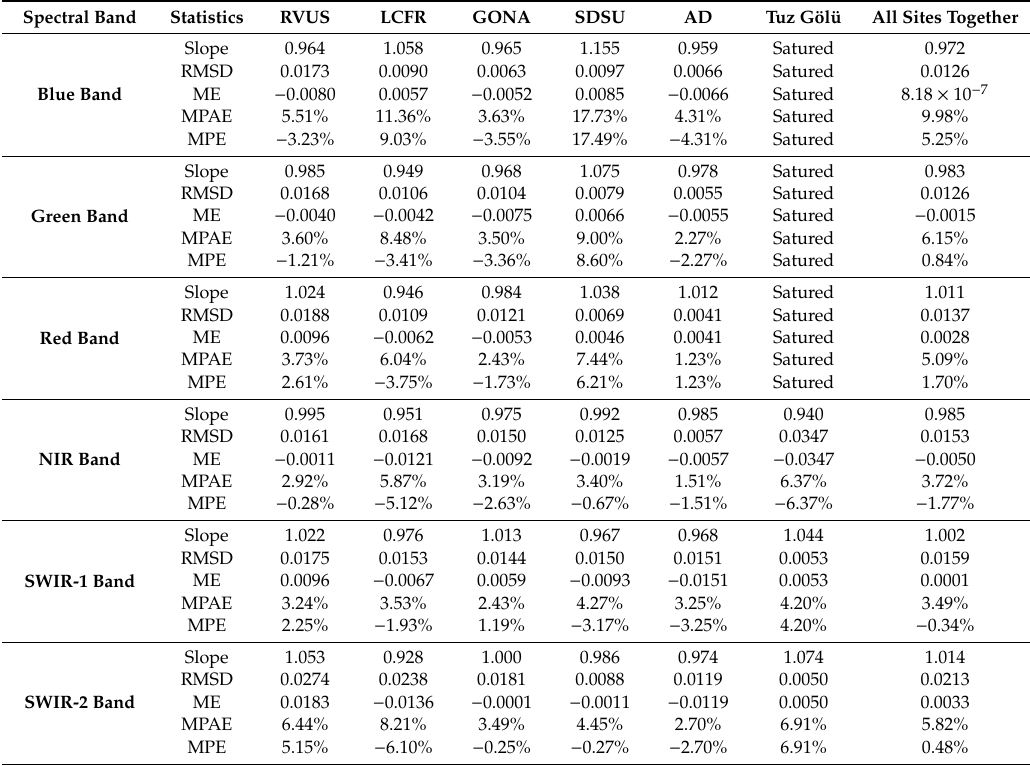
Figure 16. Temporal trends, by band, of residuals errors in surface reflectance predicted from in situ measurement and Landsat-7 ETM+ Level-2 surface reflectance data. Table 4. Comparison between surface reflectance predicted from in situ measurement and the